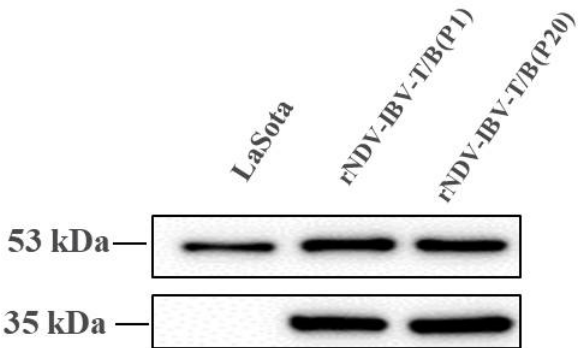
Figure 2. Western blotting of rNDV-IBV-T / B in vitro. DF1 cells were infected with one MOI rNDV-IBV-T / B and the parental NDV LaSota strain. Samples were harvested from DF1 cell lysates 24 h post-infection, and IBV-T / B epitope cassette and NP proteins were detected as approximately 35 kDa and 53 kDa bands, respectively. The LaSota strain was only detected as an NP protein band.